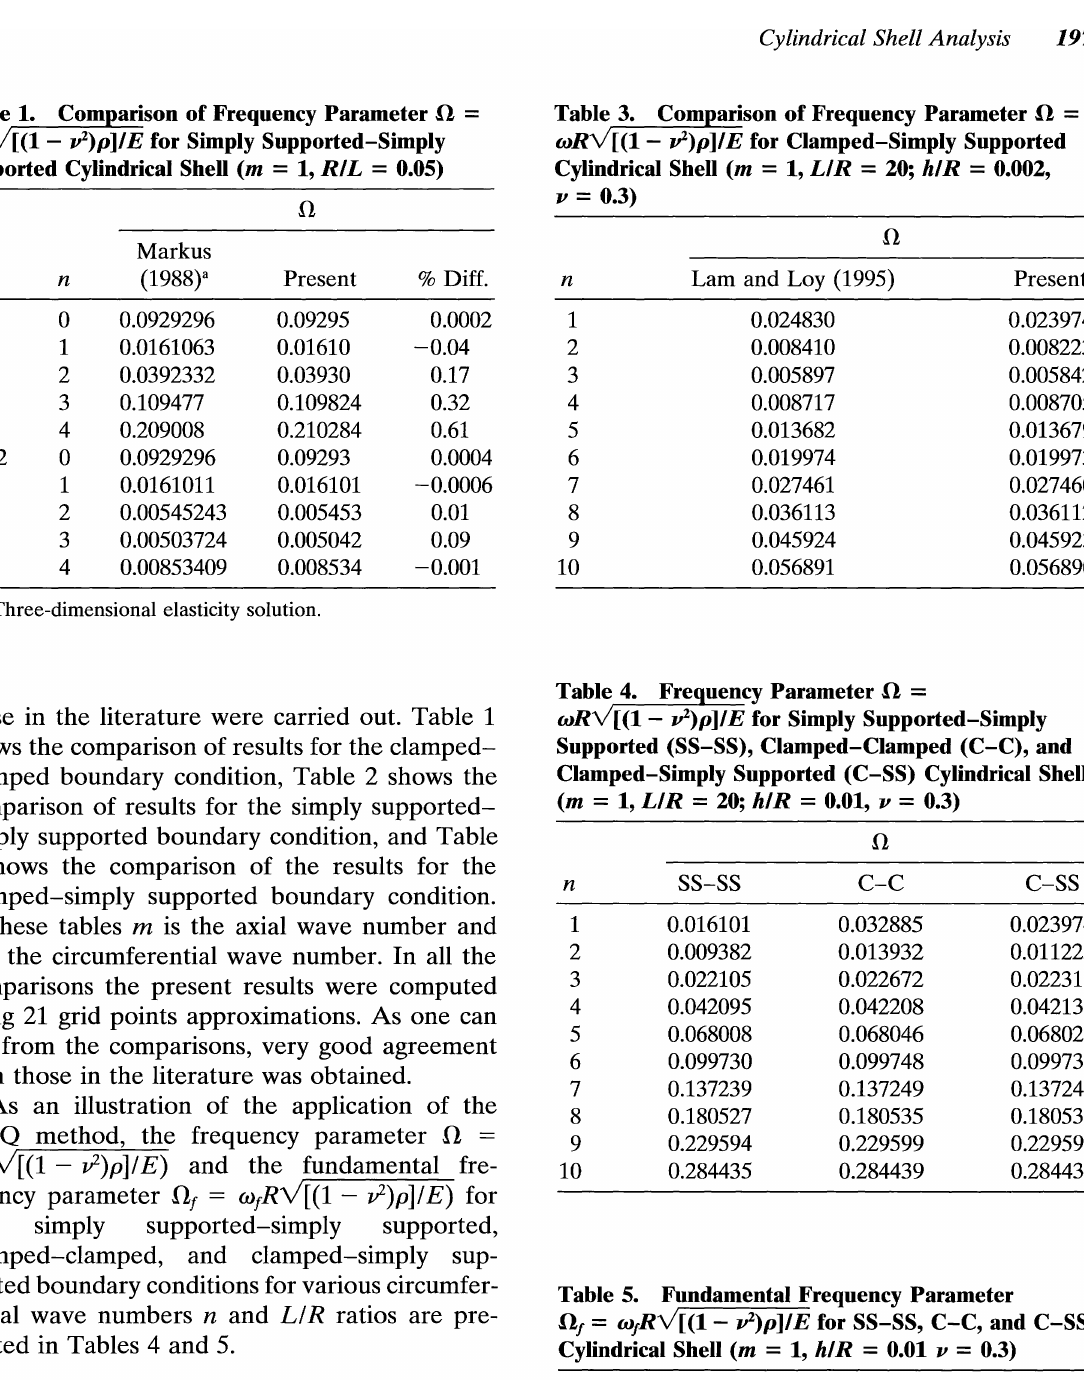
Table 2. Comparison of Frequency Parameter 0 = wRY[(I- ,r)p]IE for Clamped-Clamped Cylindrical Shell (p = 0.3, m = 1) Case LlR = 10, Rlh = 500, n = 4 LlR = 10, Rlh = 20, n = 2 LlR = 2, Rlh = 20, n = 3